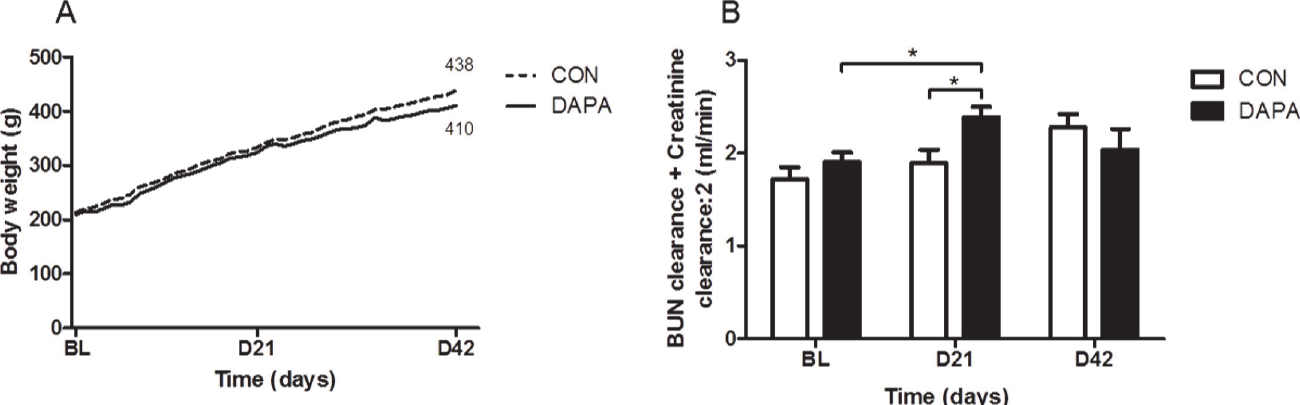
Fig 1. Effect of DAPA on body weight and renal function. Course of body weight in vehicle (CON) and dapagliflozin (DAPA) treated PCK rats during the 6 week treatment phase (A). [Clearance creatinine + Clearance BUN / 2] at baseline (BL) and after 21 and 42 days of treatment in PCK rats (B). N = 8 per group. Data are expressed as means ± SE. * P <